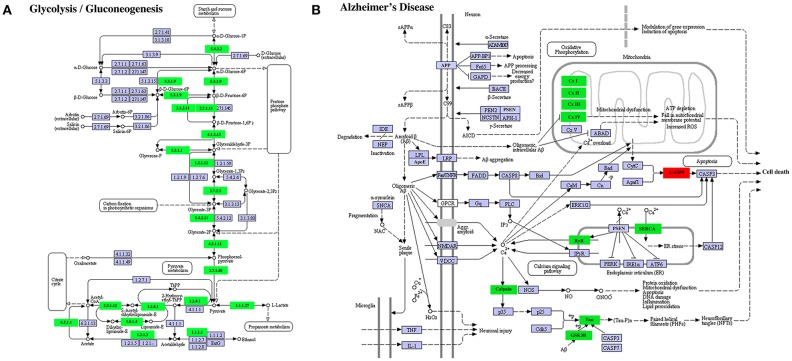
Selected enriched KEGG pathways among DETs between S41 and S43 during tail resorption. (A) Glycolysis/Gluconeogenesis pathway. Note that nearly all were downregulated between S41 and S43. A rectangle indicates a gene product (an enzyme). The down-regulated genes are shown in green. The light blue genes have no change in expression level. The numbers in the all boxes correspond to the enzyme commission numbers which are associated with a recommended name for the respective enzyme and clear circles indicate metabolic products. (B) Alzheimer's disease pathway. Note that all but one DETs were downregulated. The exception was CASP9, which is important for inducing cell death and not surprisingly upregulated. Green color indicates down-regulated DETs and red represents up-regulated DETs.